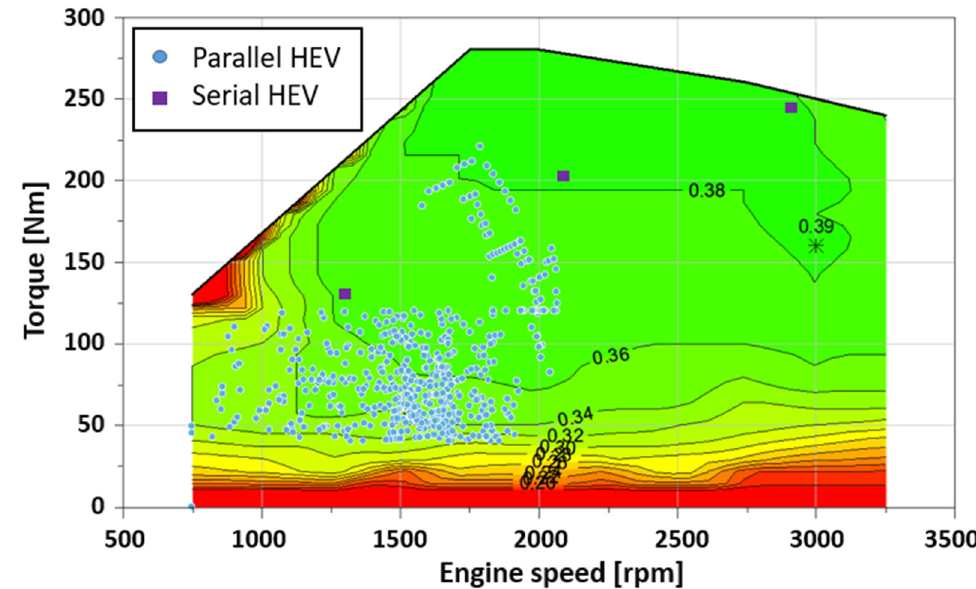
Figure 8. Operating point distribution of the ICE for a parallel hybrid and a serial hybrid on WLTC (1.6 L CI engine). (1.6 L CI